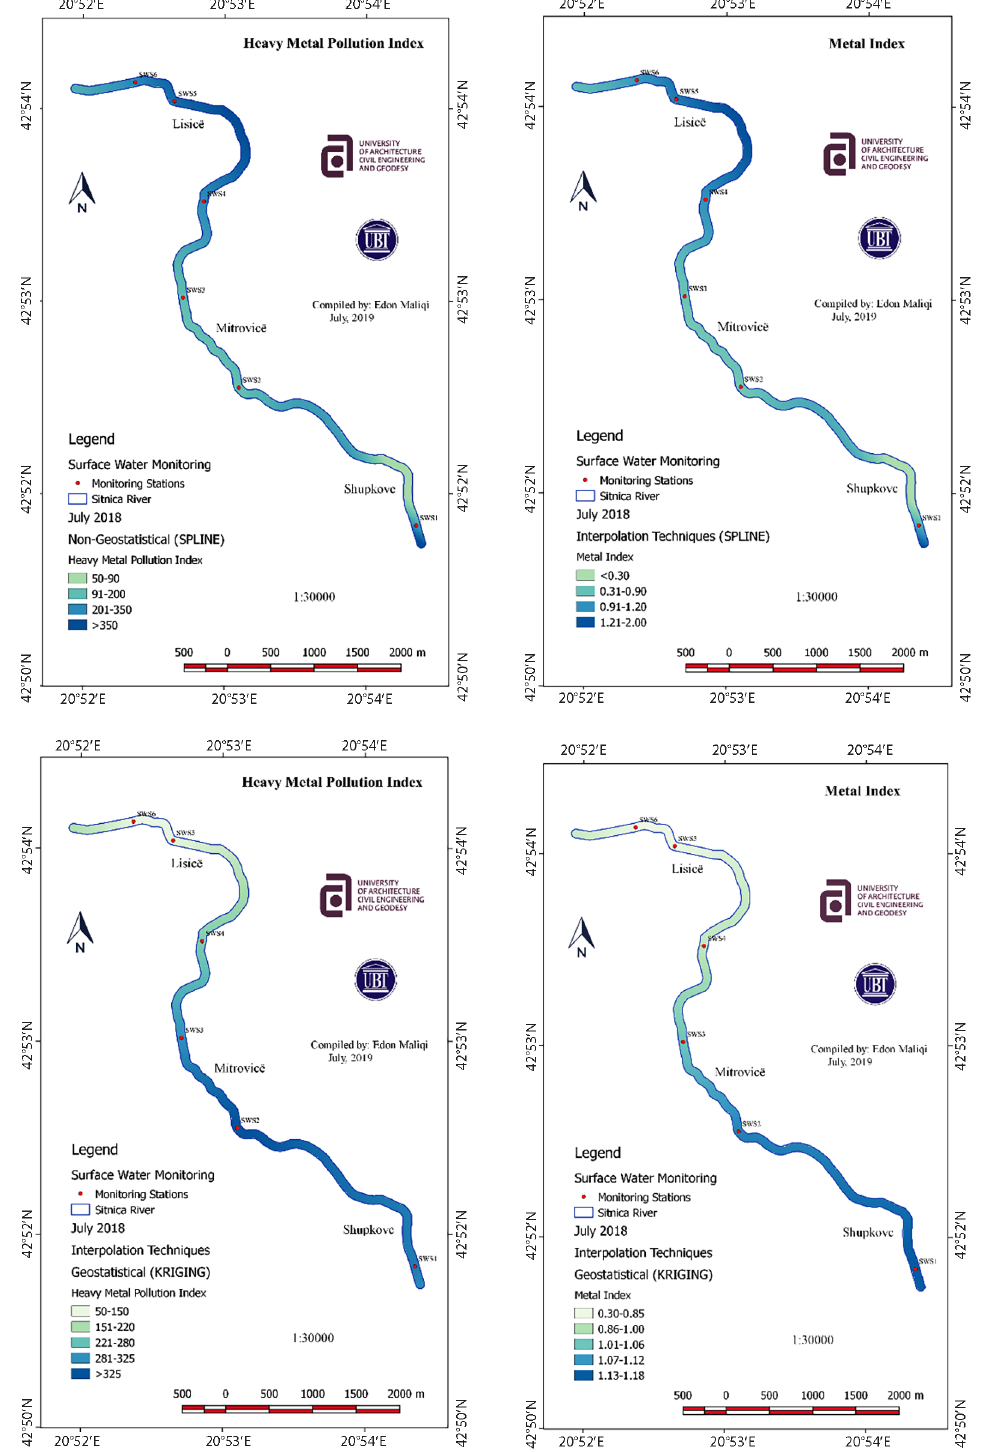
Figure 6. Thematic maps of July (2018) by using Spline and Kriging (HPI &